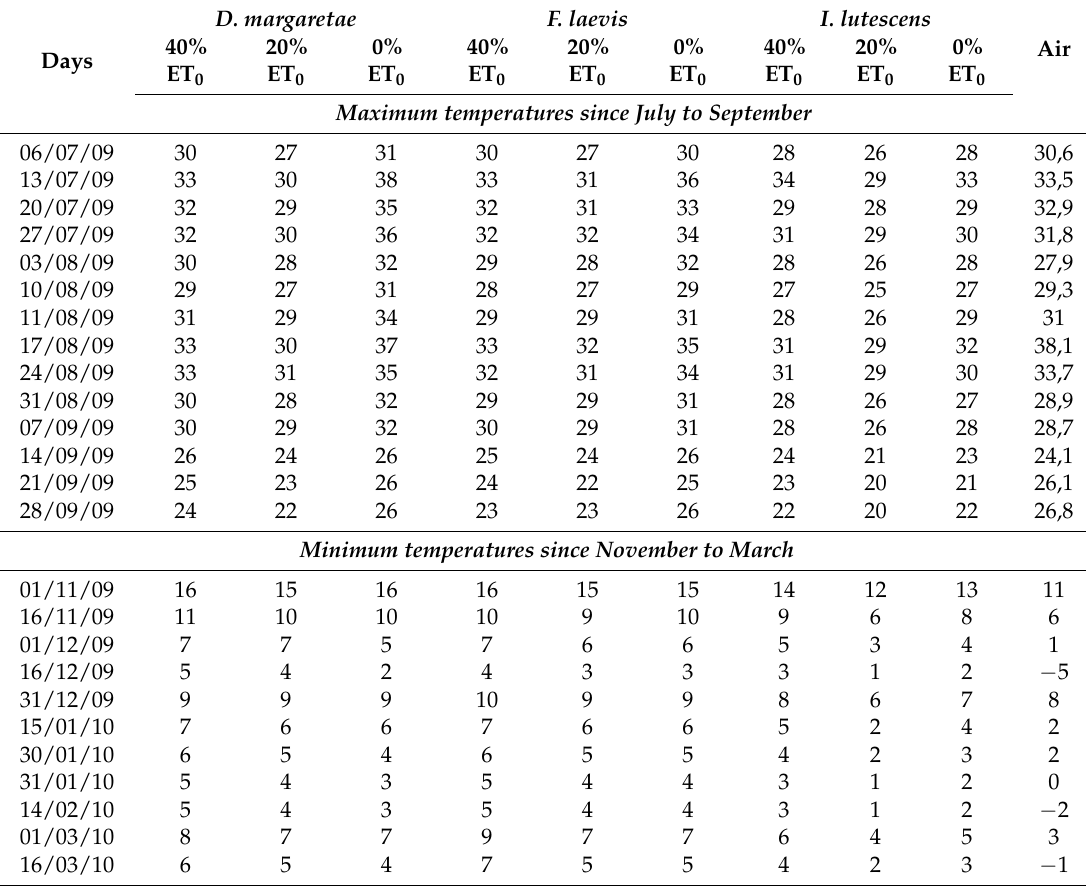
Table A1. The daily data of Maximum (From July to September) and the Minimum (From November to March) values of substrate’s Temperatures in relation to the air